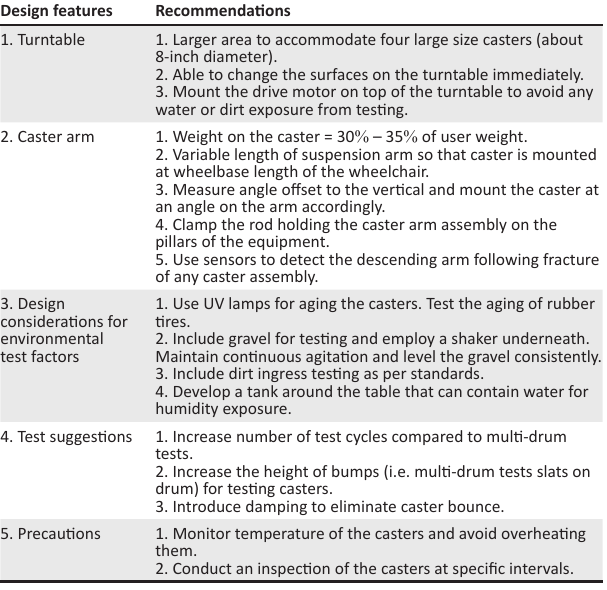
TABLE 3: Design recommendations by ISWP-SWG for turntable test